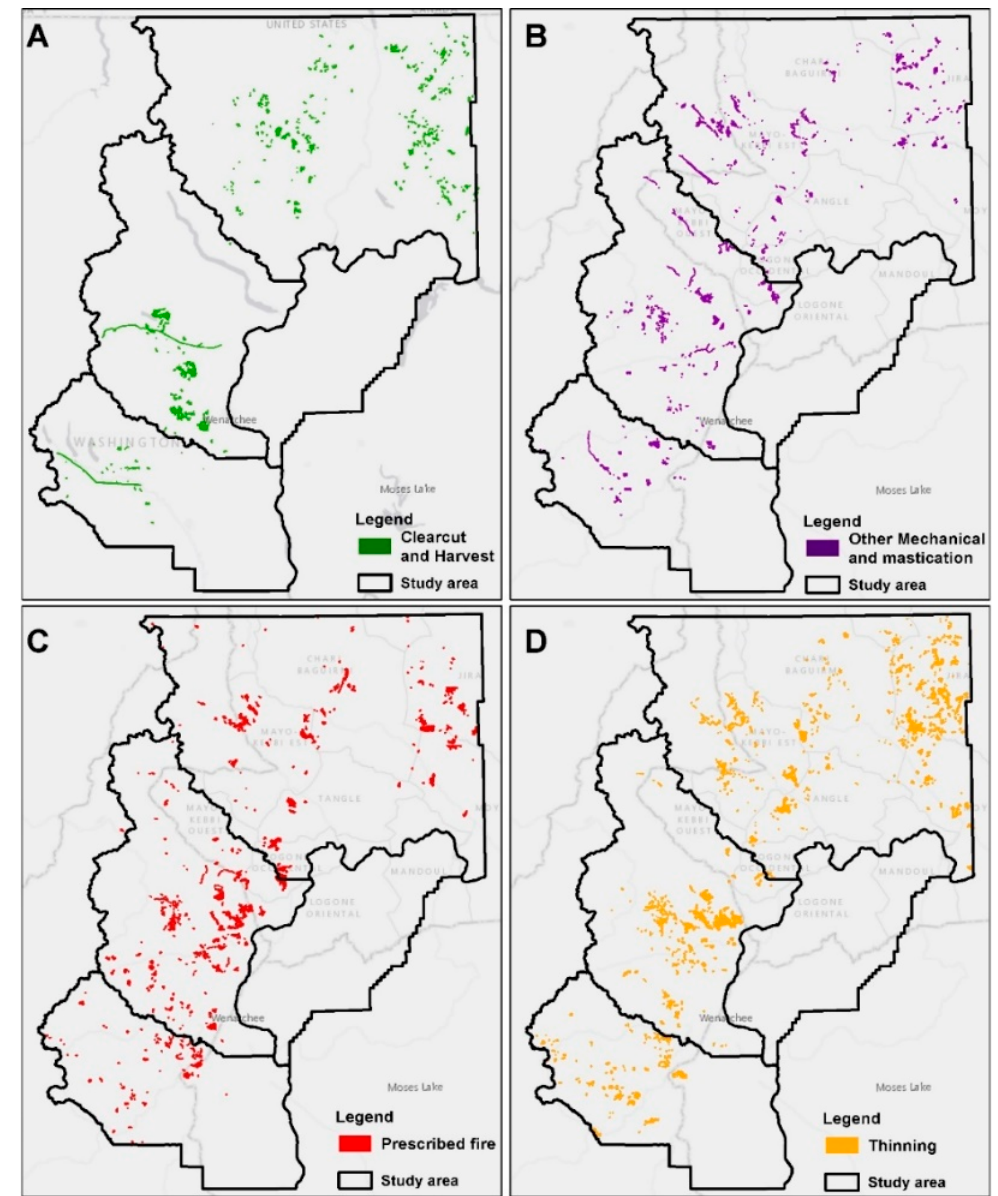
Figure 6. Spatial distribution of fuel treatment types across the study area for the period 1999–2019. ( A ) Clearcut and harvest; ( B ) Other mechanical and mastication; ( C ) Prescribed fire; ( D ) Thinning.